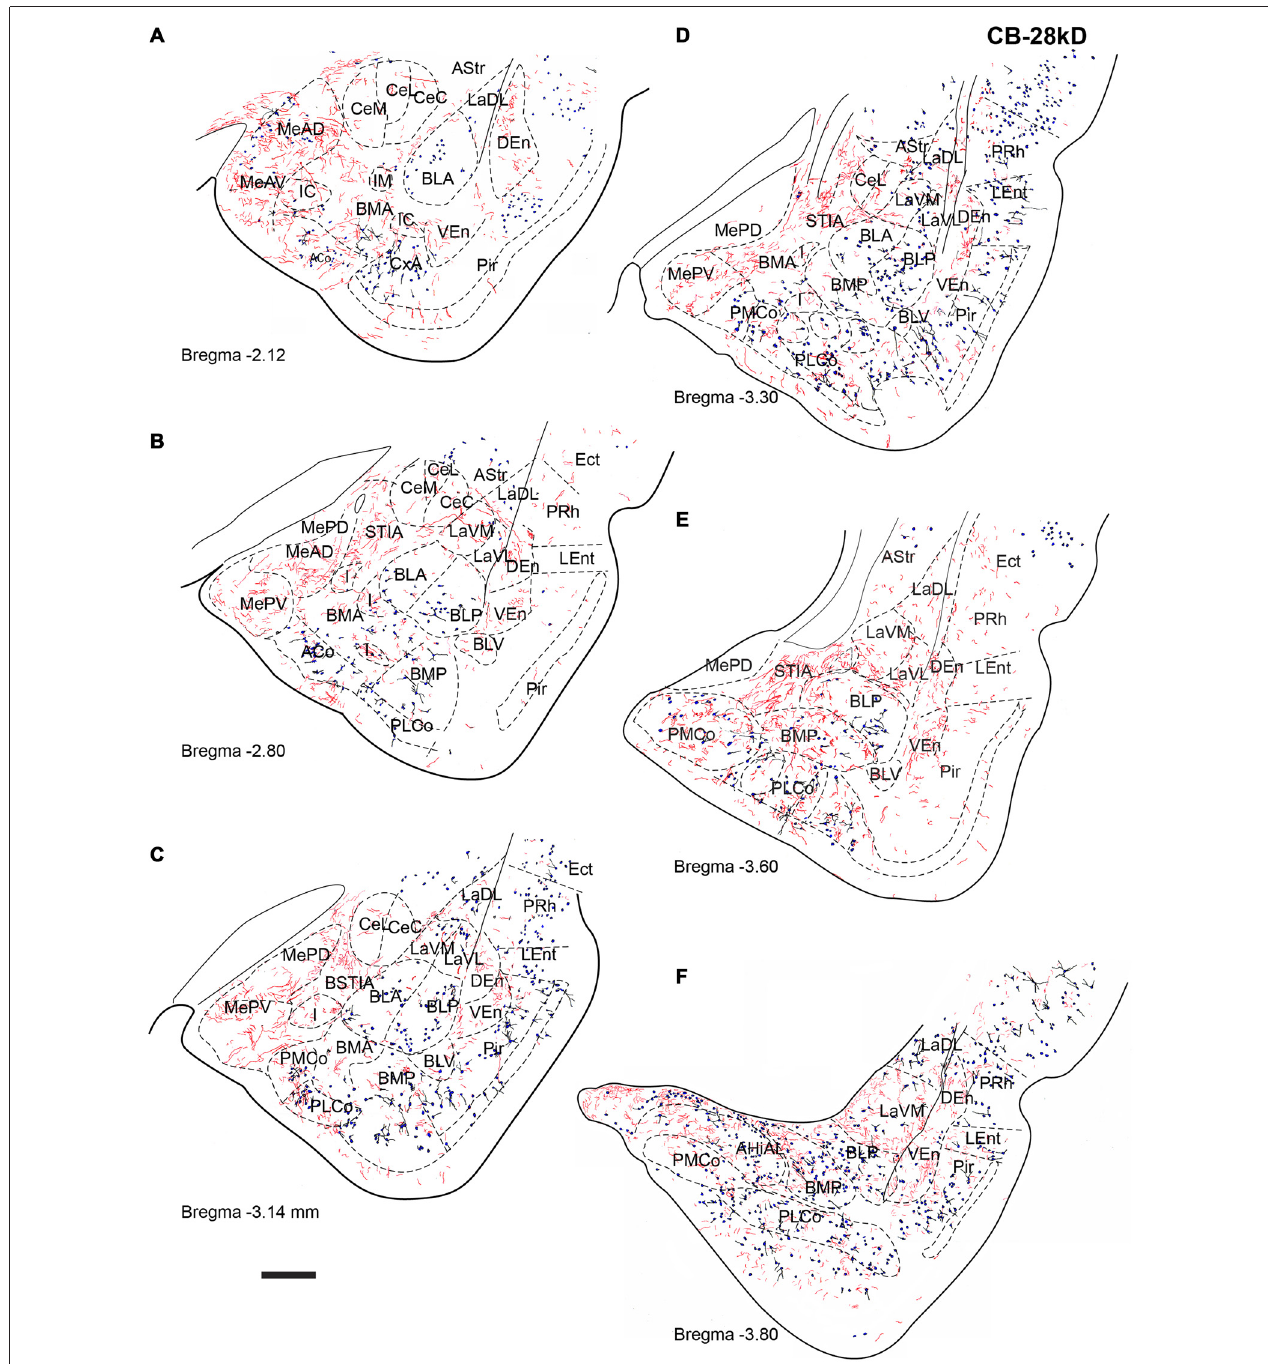
FIGURE 6 | Distribution of relaxin-3-positive fibers in the TA relative to the distribution of CB-28kD-positive neurons . Relaxin-3 fibers located in the medial amygdala areas. (A–F) Camera lucida drawings of the corresponding Bregma levels. Calibration bar 250 µ m.